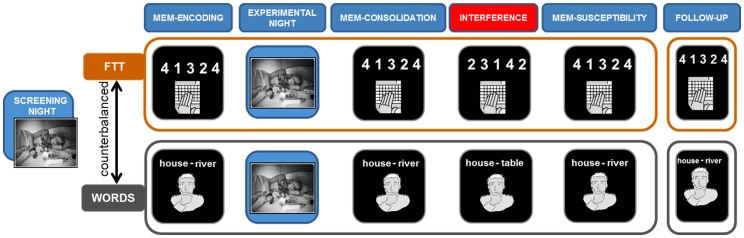
Experimental design.All subjects slept three nights in the sleep laboratory. Whereas the first night was only used for screening and adaptation purposes, nights 2 and 3 served as experimental nights (EXPERIMENTAL NIGHT). Preceding each EXPERIMENTAL NIGHT, subjects either learned (MEMORY ENCODING)the finger tapping task (FTT) or the declarative memory task (WORDS). Note that the order of the tasks were counterbalanced within subjects. In the morning (for either task) a cued recall testing for overnight memory consolidation (MEM-CONSOLIDATION) was followed by an interfering learning session (INTERFERENCE). Thereafter, participants were retested for the initial learning material from the previous day (MEM-SUCEPTIBILITY). A Follow up testing session was done in a subgroup of the study population to control for long-term effects (FOLLOW-UP).